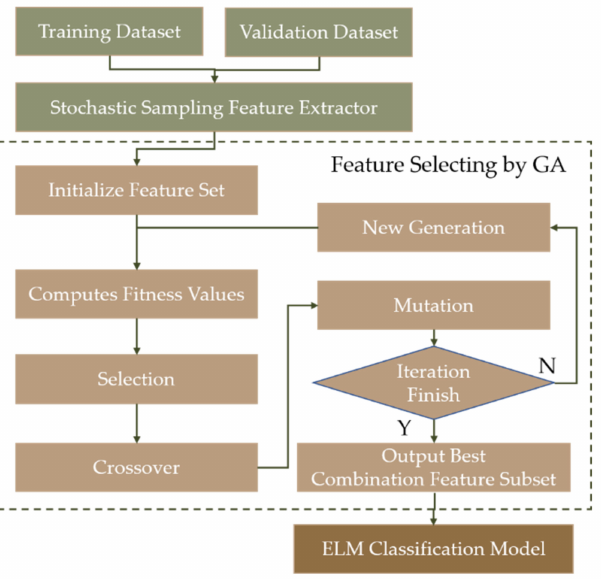
Figure 5. Flow chart for feature selection with genetic algorithm. GA: Genetic